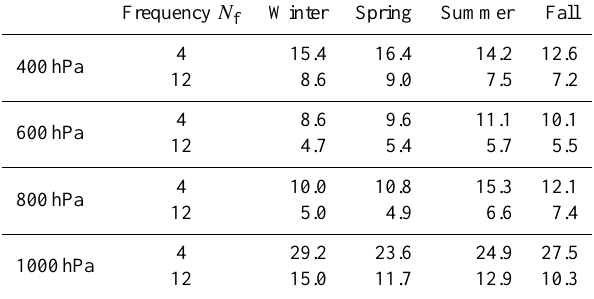
Table 3. Climatological sampling uncertainty, defined as the 2 . 6 · s samp , N f (see Sect. 3.5.2 for details). Values are given for the “regu- seas , clim lar” sampling method in percentages relative to the overall seasonal mean at both sampling frequencies ( N f = 4 or 12 profiles a month) and at four pressure levels.